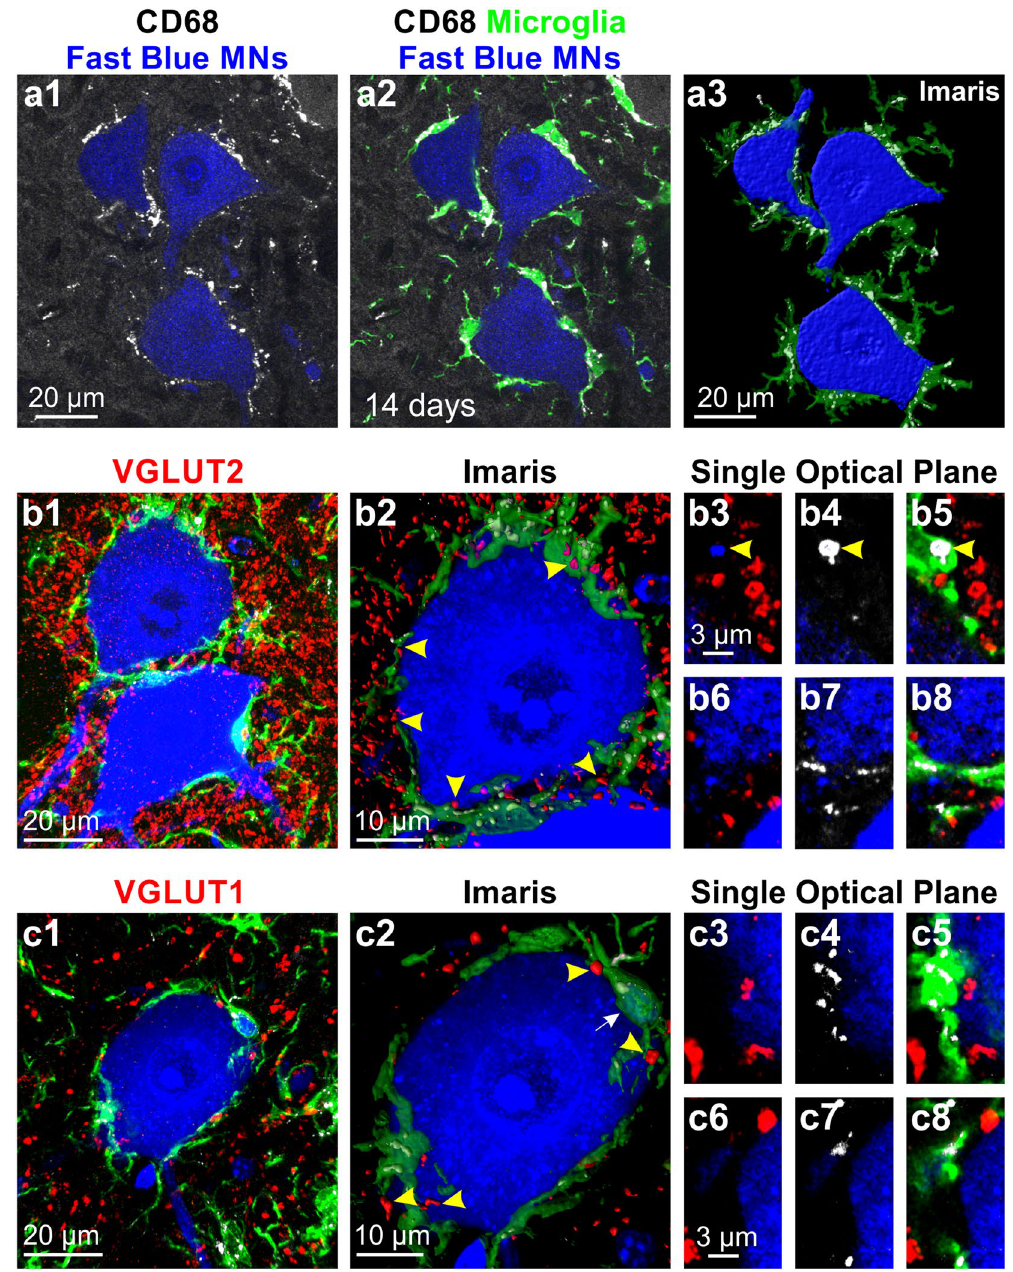
Figure 7. CD68 granules concentrate at the microglia surface interacting with axotomized motoneurons but do not engulf excitatory synapses. ( a ) High magnification confocal image of LG Fast Blue labeled motoneurons 14 days after axotomy showing CD68 immunoreactivity surrounding the cell bodies (white) in ( a1) . This CD68 –IR granules are inside microglia processes opposite to the motoneuron surface ( a2 , green CX3CR1-GFP). ( a3 ) Volume rendering of the motoneurons, apposed microglia and CD68 granules contained within the microglia processes. ( b1,c1) High magnification confocal images of Fast Blue labeled motoneurons 14 days post injury surrounded by Iba1 + microglia (green) with high density of CD68-IR granules (white) in combination with excitatory synaptic markers VGLUT2 ( b1 ) and VLGUT1 ( c1 ). Each collapsed confocal image stack contains 15 image planes taken at 0.5 µ m z steps. ( b2, c2) Zoomed Imaris volume renderings of motoneuron cell bodies and microglia with close by VGLUT2 ( b2 ) and VGLUT1 ( c2 ) synaptic boutons. Yellow arrows show VGLUT synaptic inputs close to microglia, but always outside. White arrow in c2 indicates a microglia cell nucleus filled with Fast Blue content. There was no clear evidence of reactive microglia engulfing excitatory inputs or of CD68 + granules incorporating VGLUT synaptic material. ( b3–b8, c3–c8) Single optical planes of the confocal images stacks from b1 and c1 show no co-localization between VGLUT2 or VGLUT1 and CD68 granules. Yellow arrowhead in b3–b5 show a CD68 + phagosome containing Fast